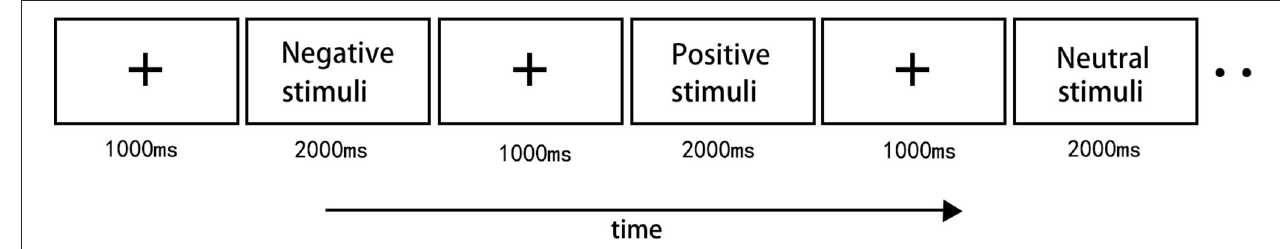
FIGURE 1 | Illustration of the stimulus paradigm applied. There were total 45 images for three stimulus type. 15 positive images, 15 neutral images and 15 negative images were presented with pseudorandom order. The trial began with a fixation mark on the black screen for 1,000ms, and then an image appeared for 2,000ms. There were 3 blocks in total.